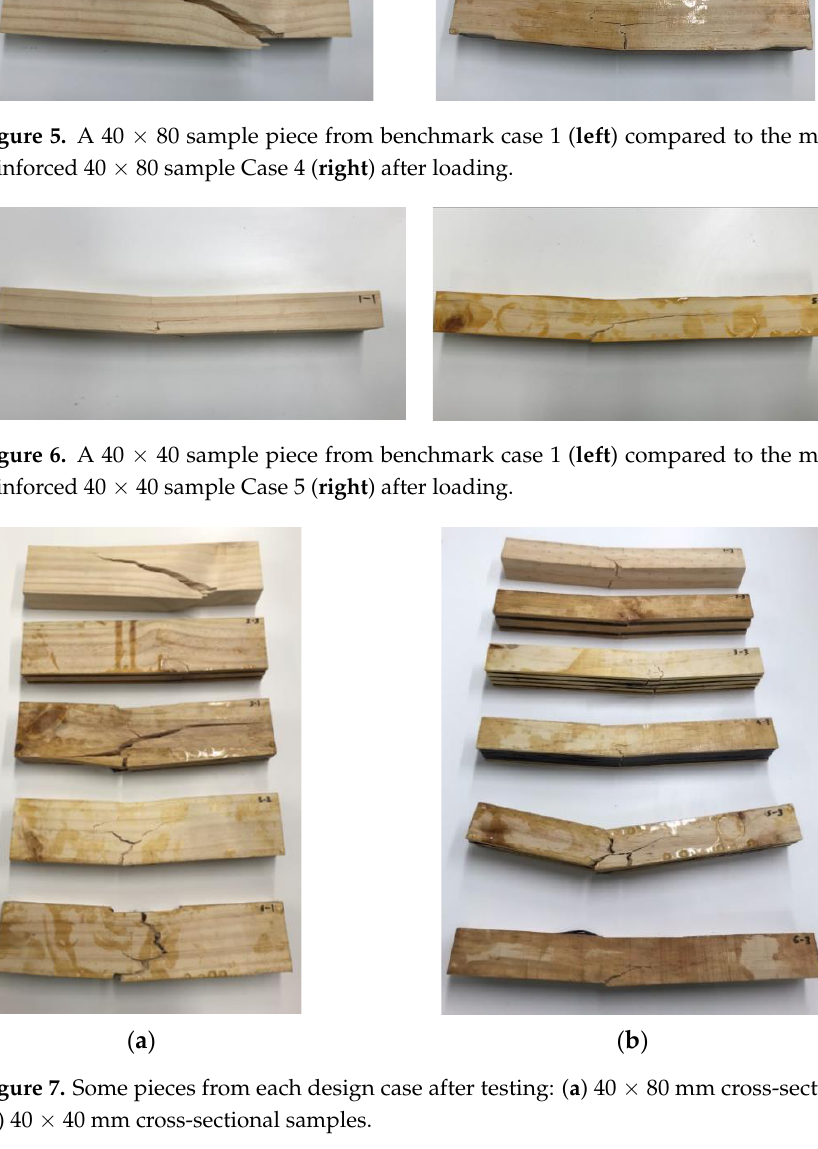
( b ) Figure 8. Load vs. extension graph of ( a ) Case 1, 40 × 80 sample pieces, vs. Case 4, 40 × 80 sample pieces; and ( b ) Case 1, 40 × 40 sample pieces, vs. Case 5, 40 × 40 sample pieces. Pseudo-ductility can be further explained through the changes in E-modulus or mod- ulus of elasticity (MOE) and time at break, as seen in Table 2. The MOE of the unreinforced cases in both sets of samples (Case 1) resembled the MOE of radiata pine species, which ranged between 2200 – 4700 MPa [22]. However, in the reinforced cases we saw changes in the MOE and time at break that differed with each set. For the set of 40 × 80 samples, the MOE decreased, which indicated the shift to ductility. This set’s time at break also drasti- cally increased, implying a slower deformation. However, as the carbon ratio increased with the small cross-section (40 × 40), the MOE increased, hence shifting back to brittleness even slightly more than the benchmark case 1. The time at break for this set was almost similar to the benchmark case. Figure 9 compares the flexure stress and flexure strain